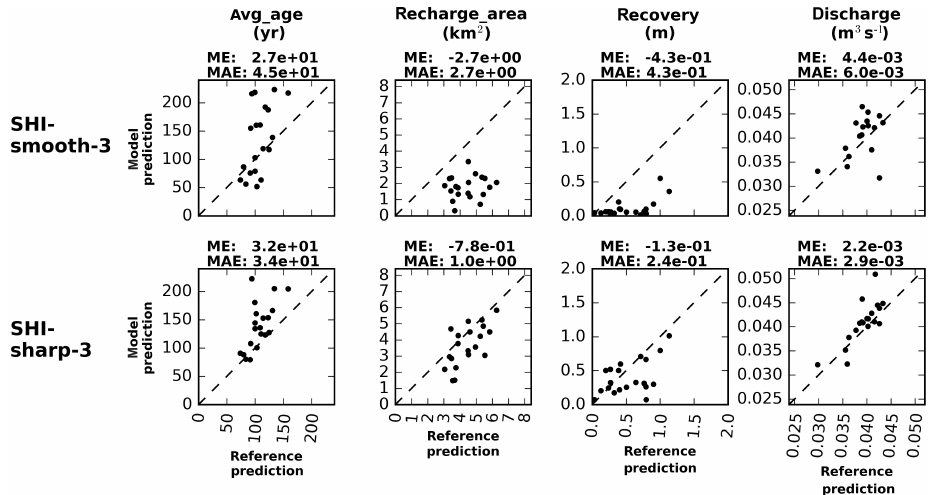
Figure 9. Scatter plots of calibrated model prediction versus the reference model prediction using results from the 20 system realizations. The plots in the first and second columns are the average groundwater age and recharge area, respectively, of the pumping well. Column three is for head recovery when pumping has stopped in the observation well shown in Fig. 10, and column four is for groundwater discharge to the river after pumping has ceased; ME and MAE are used to quantify the prediction error on the basis of the 20 realizations.